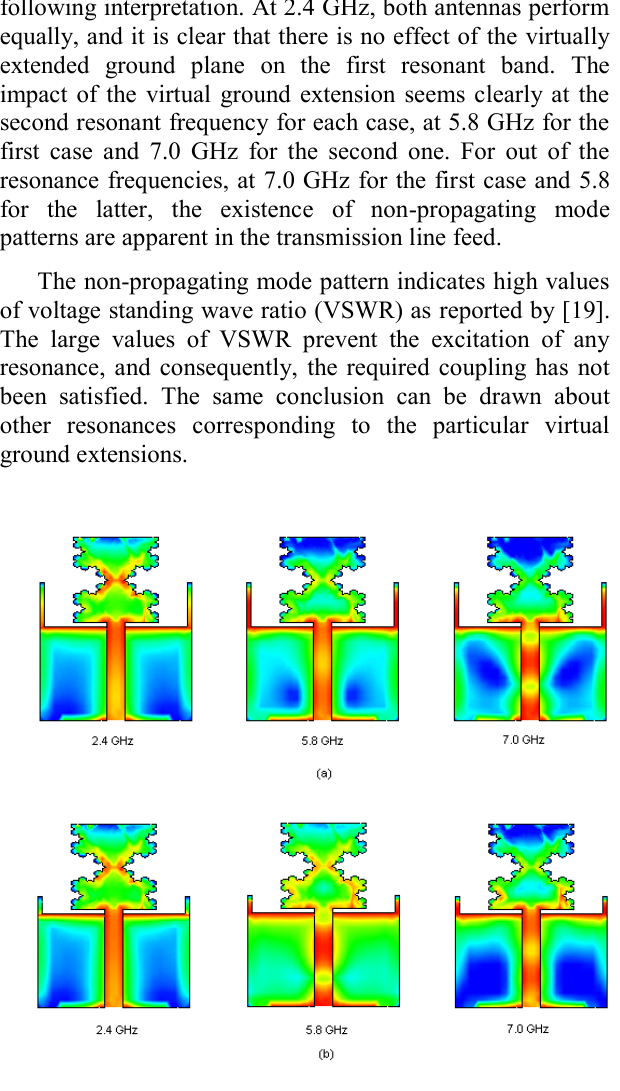
Figure 12: The surface current distributions on the 3rd iteration Koch fractal monopole antenna structures for (a) U=10 mm, and U=